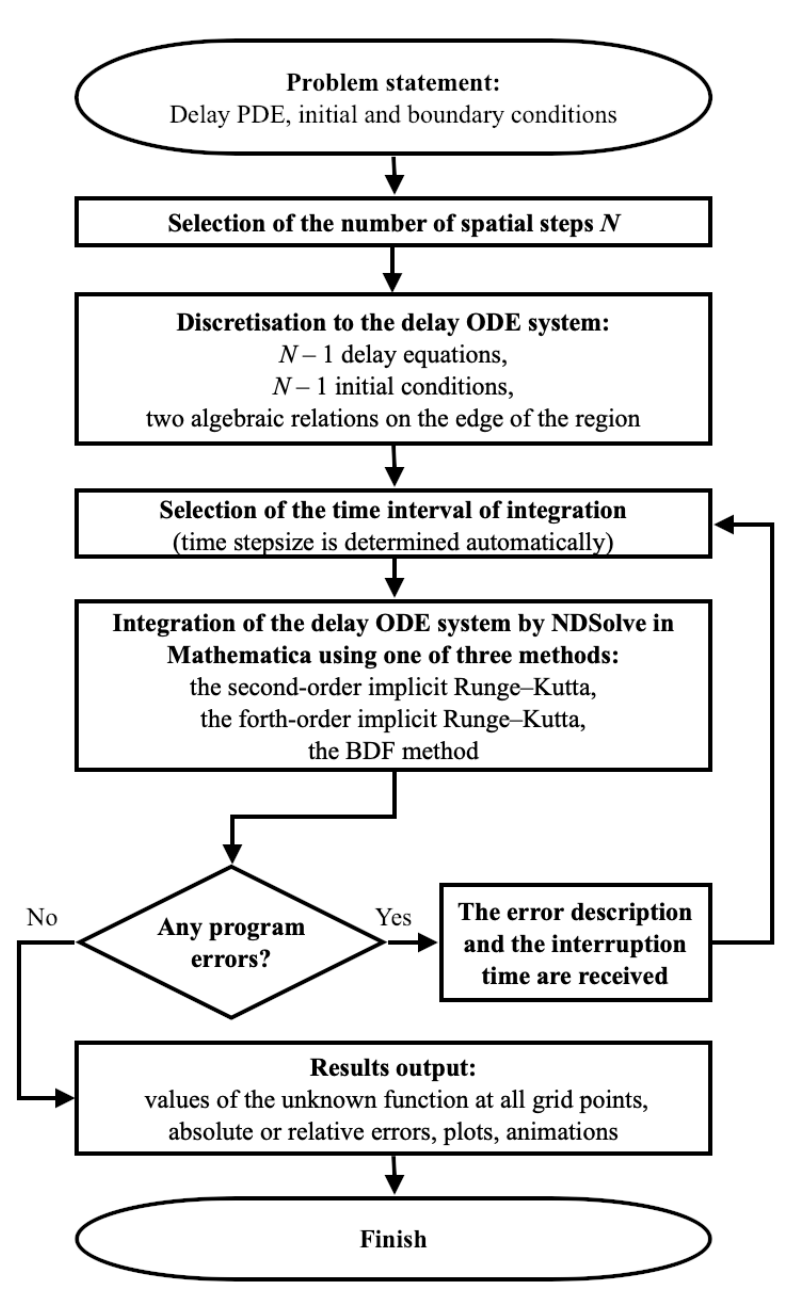
Figure 2. The flowchart of the numerical integration of delay reaction–diffusion problems by the method of